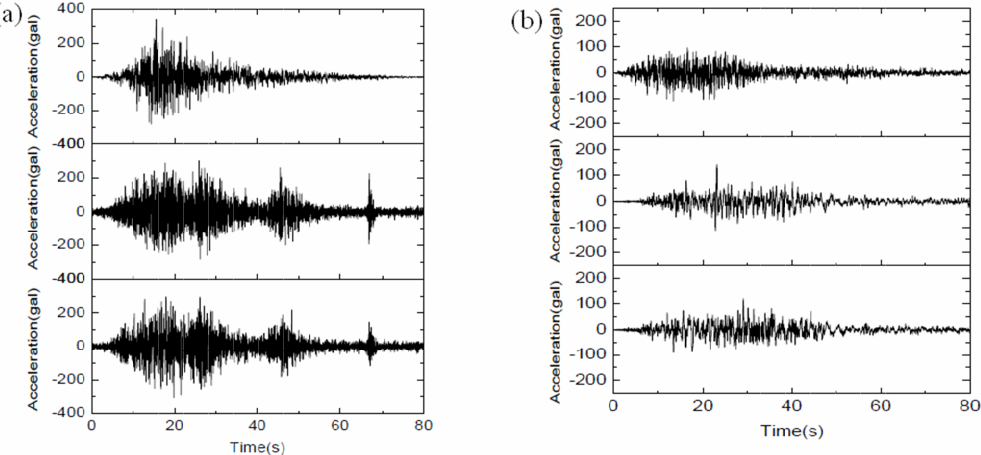
Figure 10. Acceleration time histories synthesized and observed at (a) Maoxian station (51MXT) and (b) Pixian station (51PXZ), redrawn from Tao et al. (2013).